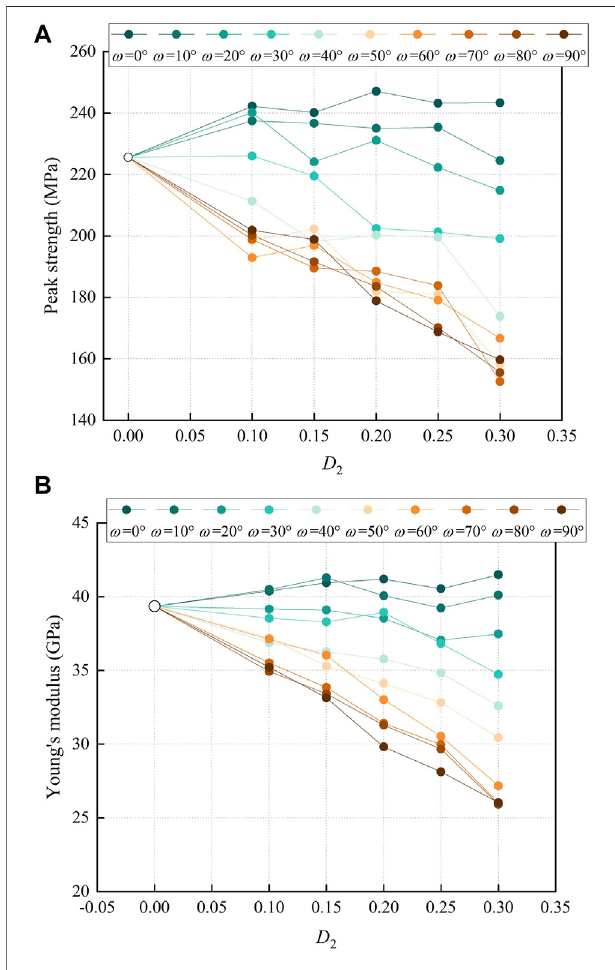
FIGURE 10 | Results of (A) compressive peak strength; and (B) corresponding Young ’ s modulus for group D2-A.